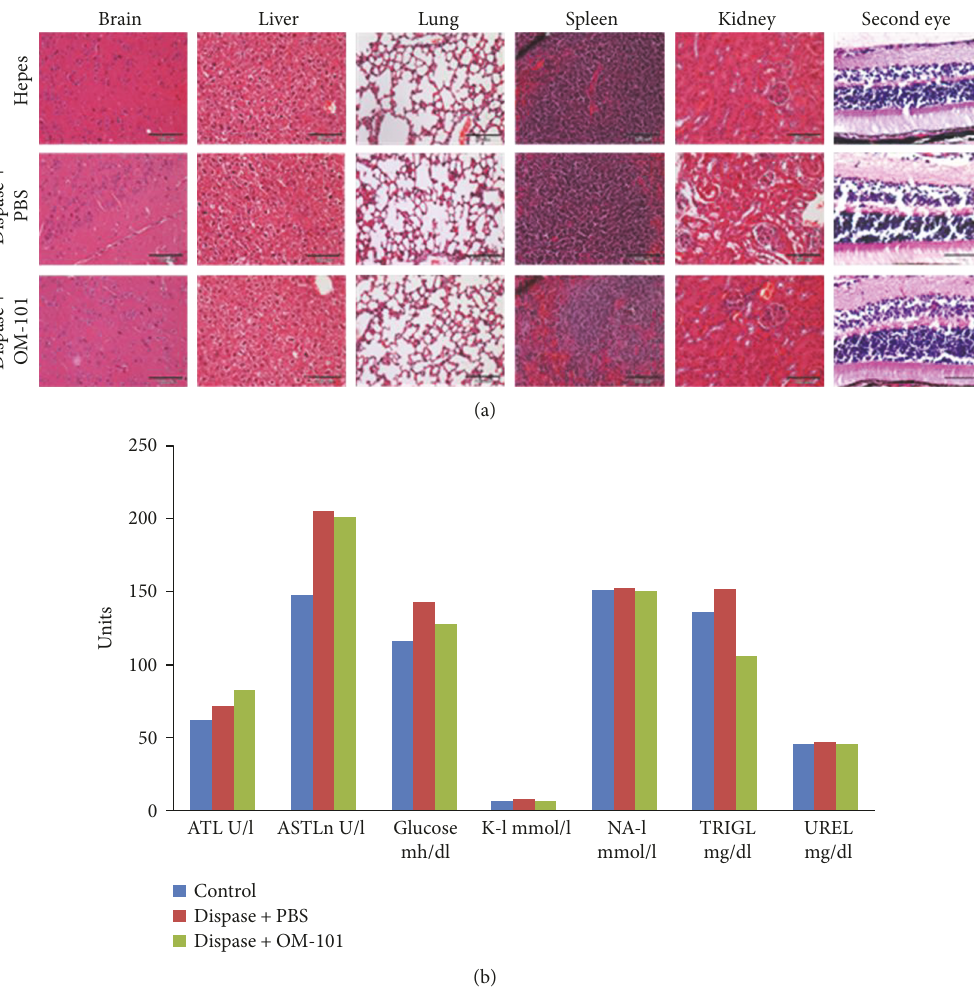
Figure 3: Safety studies of OM-101 organs (a) and blood (b) were collected from all groups. All blood parameters were found normal compared to the control group. No abnormalities were found in the histological section. Scale bar 100 μ